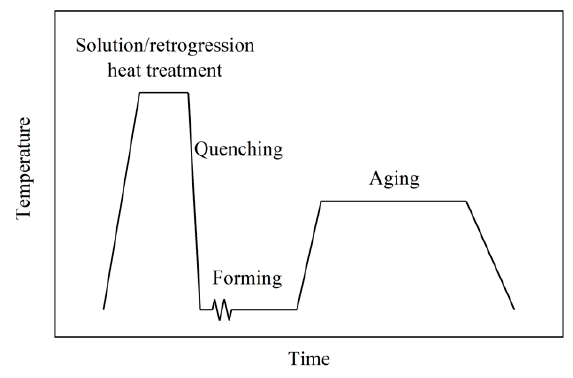
Figure 1. Sketch of the W-temper process.